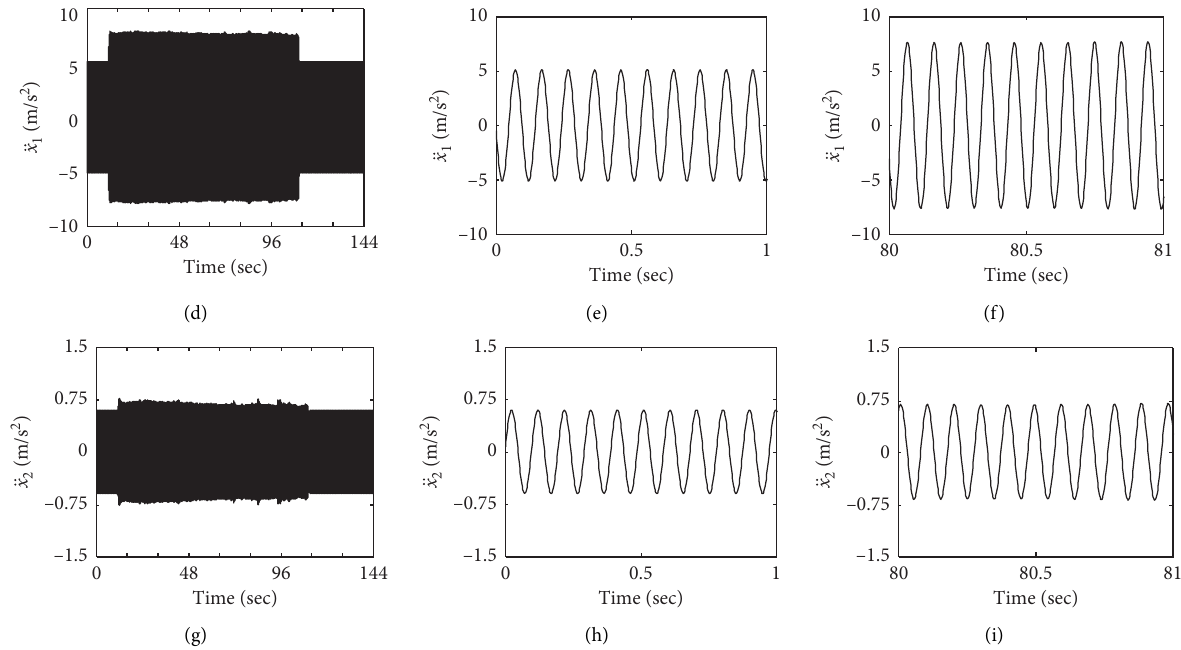
Figure 13: Time history of excitation force and system responses when Ω � 10 . 25 Hz (for t < 11s and t > 110s, α � α � 0 . 5 and τ � 96ms): (a) excitation force; (d) absorber; (g) primary system; (b, c) zoom of (a); (e, f) zoom of (d); (h, i) zoom of (g). α 1 2 2